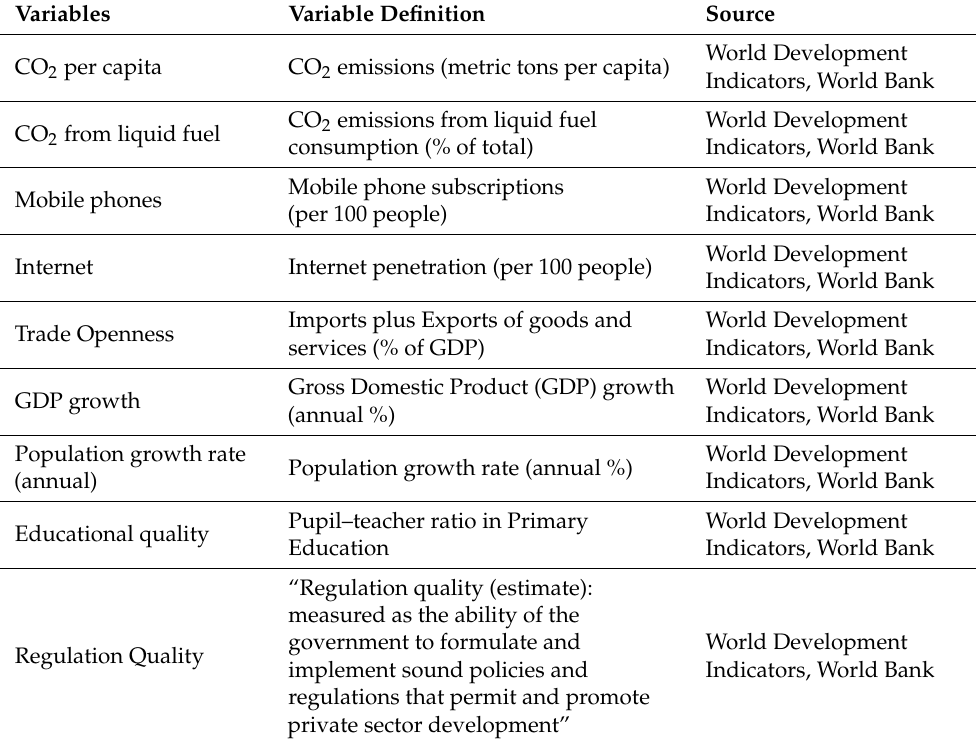
Table 1. Variable